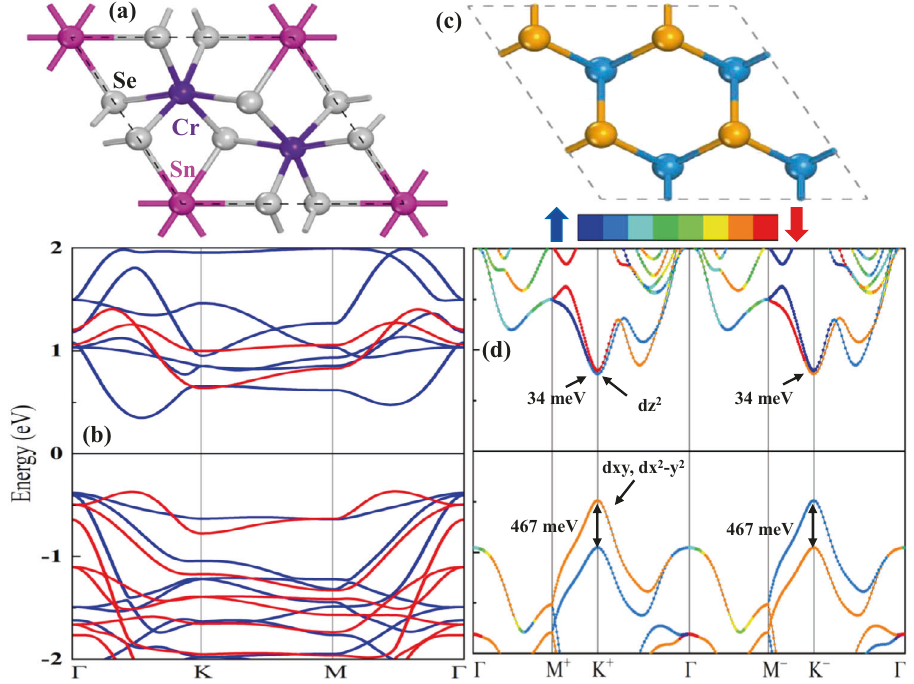
Fig. 1 Structural illustration and band structure of CrSnSe 3 and WSe 2 monolayers. a Top view of the optimized crystal structure of the CrSnSe 3 monolayer b spin-polarized band structure of CrSnSe 3 monolayer c crystal structure of the WSe 2 monolayer, and d band structure of the WSe 2 layer without vdW corrections including spin-orbit-coupling along the [001]